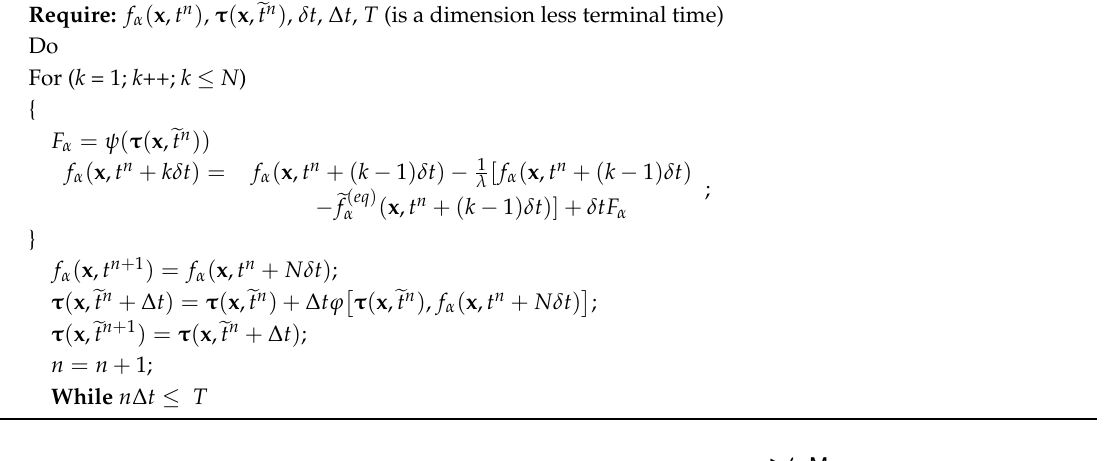
Algorithm 1. The coupled algorithm using a homogeneous time step.